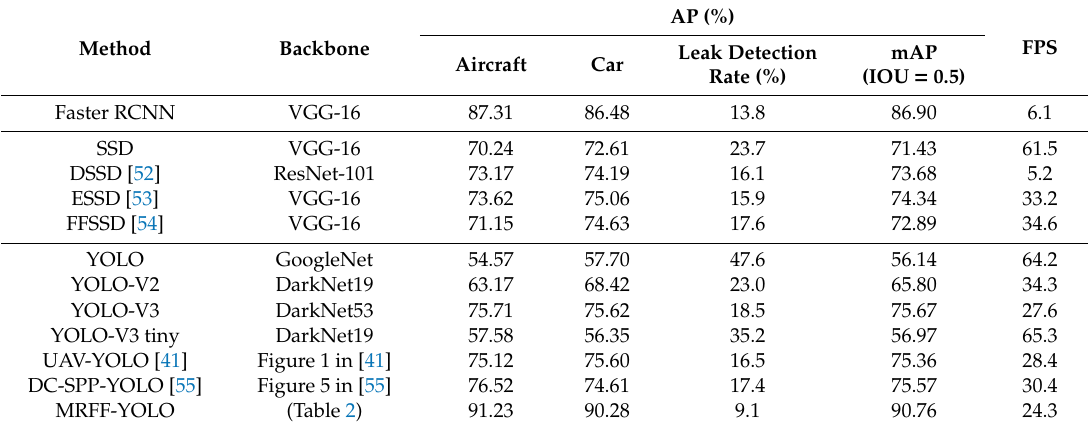
Table 11. The contrastive results in the UCS-AOD